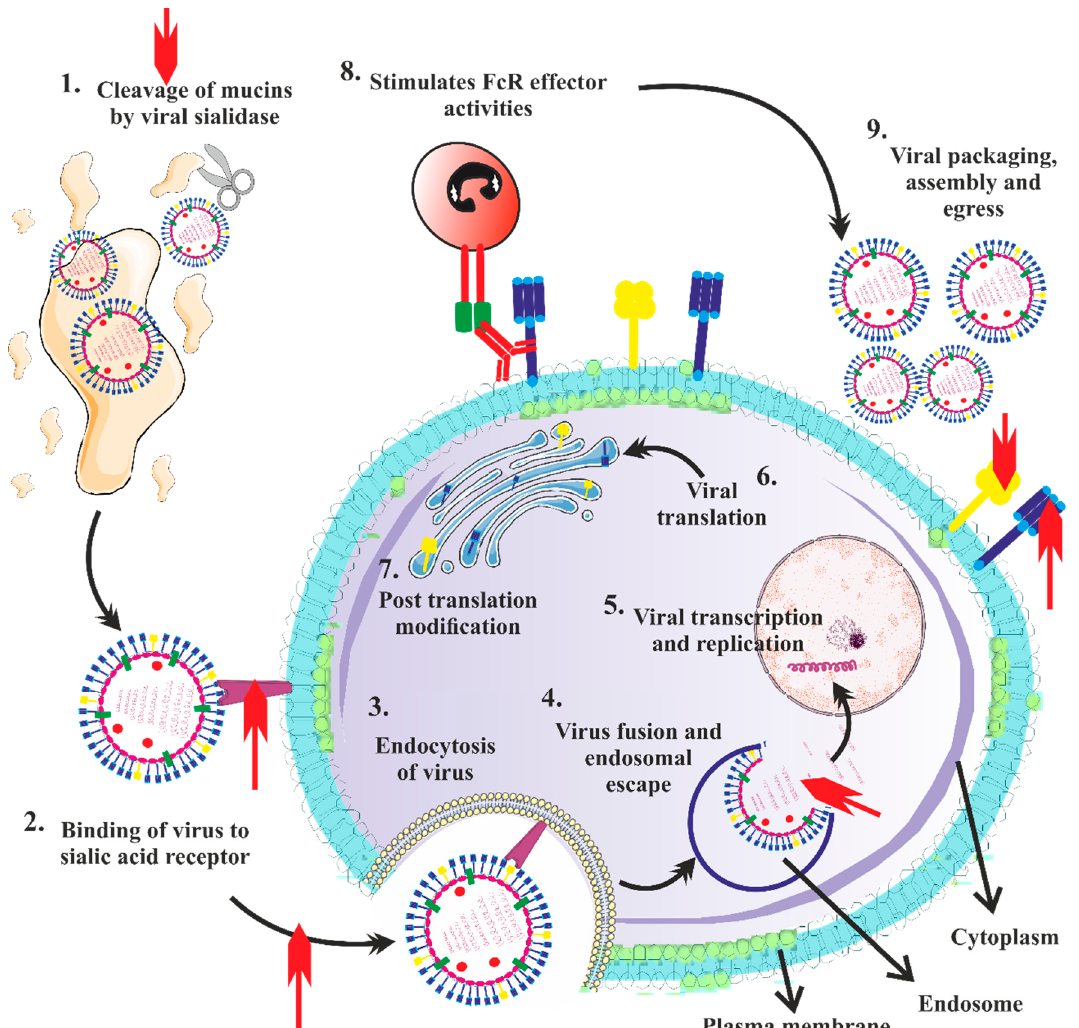
Figure 9. Schematic diagram of life cycle of influenza virus and possible targets (shown by red arrows) for defensive antibodies. (1) The viral neuraminidase (NA), an enzyme that cleaves mucins to gain access to respiratory cells, facilitates viral entrance in the respiratory tract. Antibodies that disrupt the enzymatic activity of NA, such as anti-NA antibodies or anti-hemagglutinin (HA) antibodies, may be able to stop this process. (2) The head of HA binds to sialic acid receptors on the surface of cells, thus mediating viral entrance. Endosomal escape is then accomplished by the fusing of the viral and endosomal membranes. In addition to blocking this interaction, antibodies that bind to the HA head domain can provide sterile protection from infection. (3) Alternately, blocking HA-neutralizing antibodies can prevent the internalization of the influenza virus after post-binding; or (4) its capacity to fuse and escape from the endosome. (5) For viral transcription and replication, ribonucleoproteins from the virus (vRNPs) are transported into the nucleus; (6) mRNAs are exported to the cytoplasm to be translated into viral proteins; (7) for post-translational modification and subsequent presentation on the cell surface, HA and NA are transported to the Golgi; (8) anti-HA stalk antibodies identify HA on infected cells’ surfaces and activate Fc-mediated effector mechanisms such as antibody-dependent cellular cytotoxicity, which can then be used to target and destroy the infected cell. (9) It is at the plasma membrane that viruses are packaged, assembled, and expelled. Antibodies that inhibit egress, such as anti-HA or anti-NA antibodies, may also target this pathway. Anti-NA antibodies can do this by inhibiting the release of fresh virions from the surface of infected cells or by forcing fresh virions to cluster in the absence of NA activity. The figure is adapted from Krammer, 2019 [262].